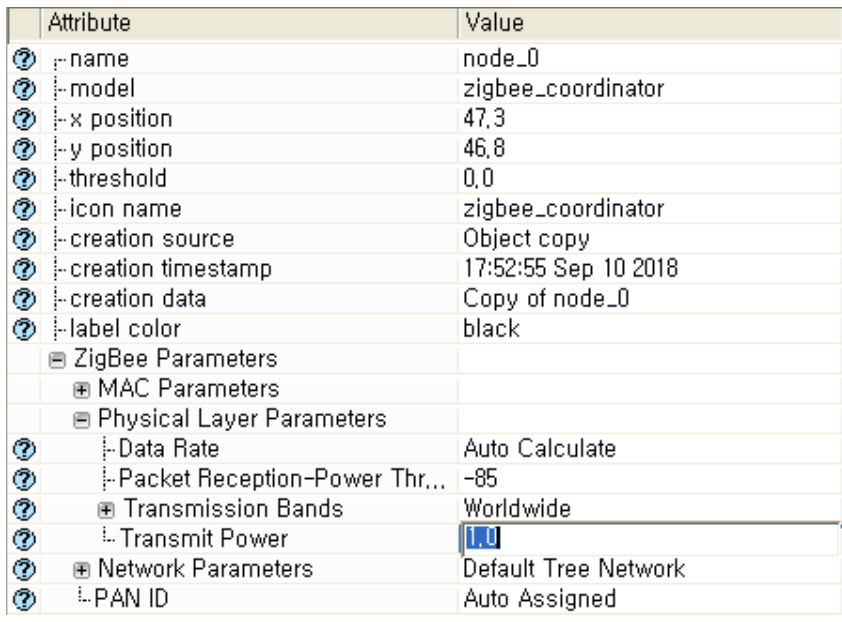
Figure 6. The Red Line (all the transmission power outputs were set at 0.1).